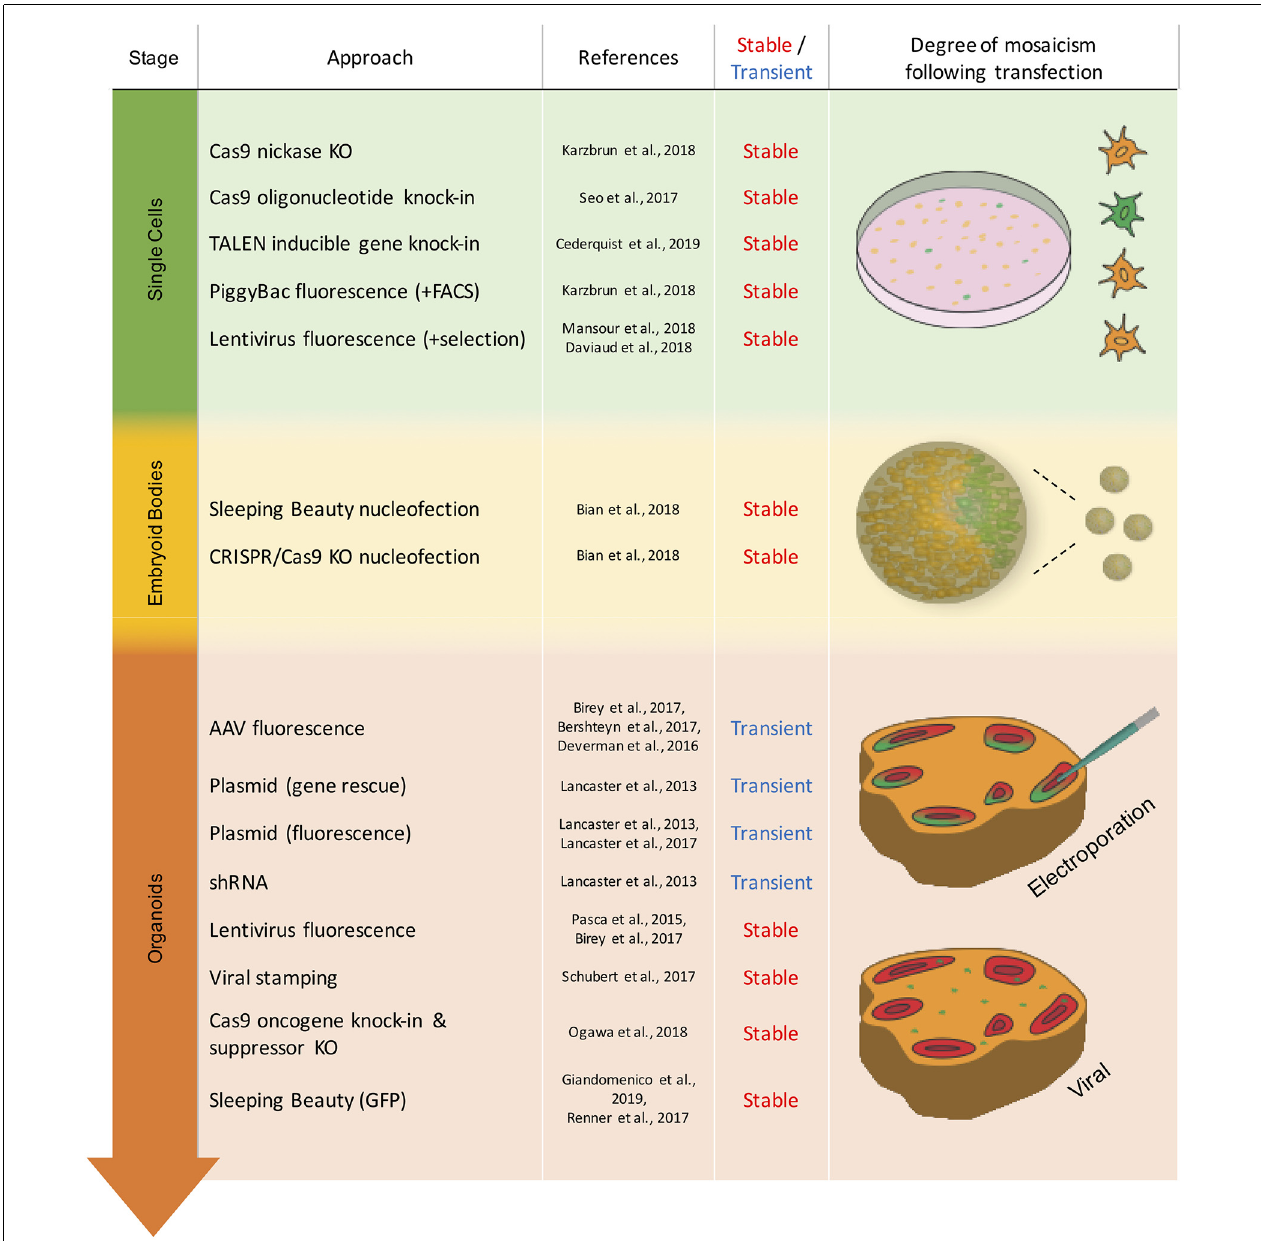
FIGURE 1 | Overview of the transient and stable approaches for genetic modification in brain organoids. Techniques are listed by the stage of organoid development in which they have been used. Schematic representation of mosaicism and spatial distribution of genetically modified cells (green) following respective modification